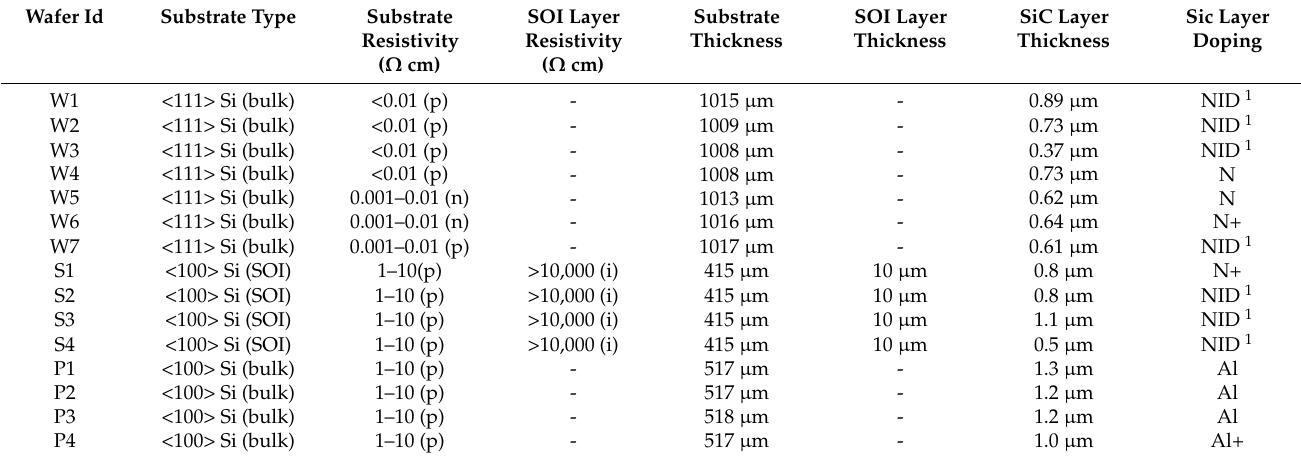
Table 1. Overview of the 3C-SiC on Si samples prepared for the experiments.